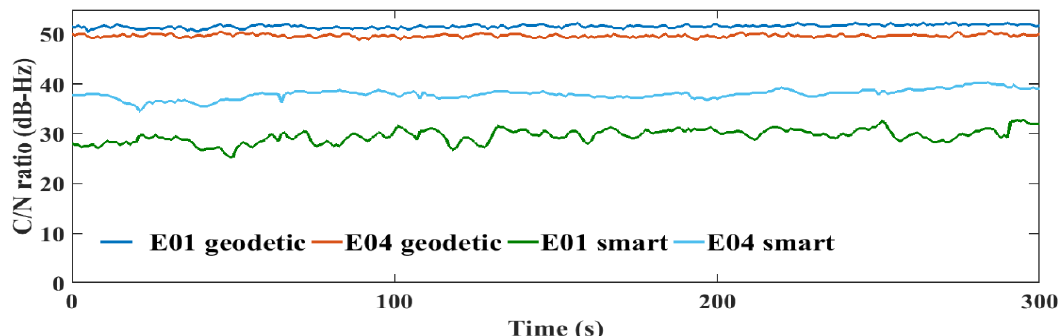
Figure 11. L5 C / N values from the geodetic receiver (geodetic) and the smartphone (smart) for Galileo.